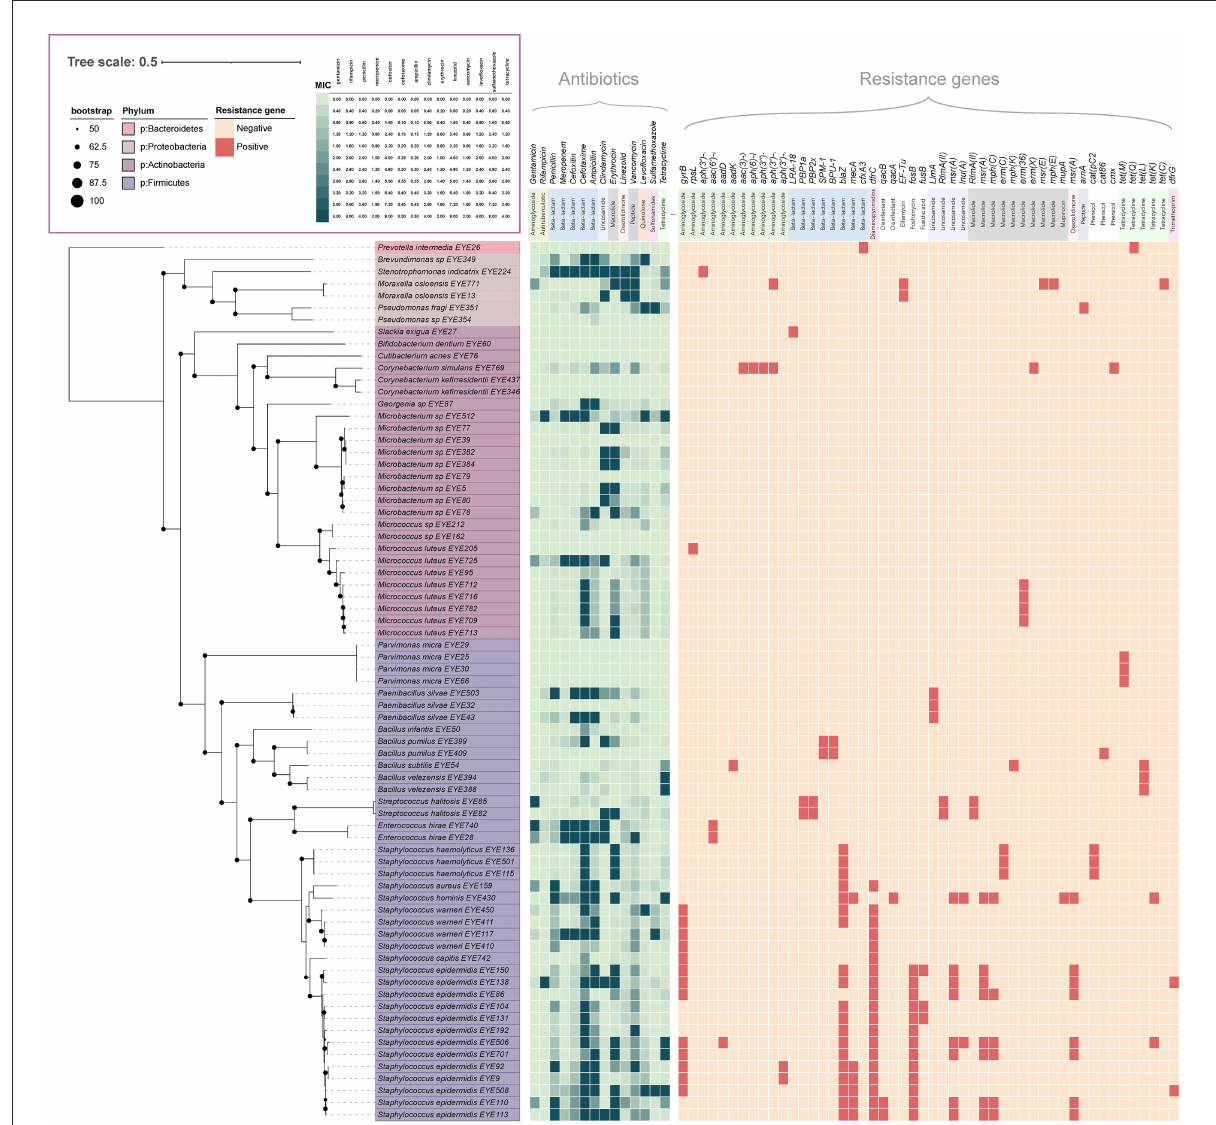
FIGURE3 Antibiotic resistance profile of ocular surface isolates. The phylogenetic tree was constructed from concatenated protein sequences using PhyloPhlAn and drawn using iTOL. Strains assigned to various phyla are displayed in different colors. All shades of green pixels represent MIC values. All red pixels represent antimicrobial resistance genes detected along each strain using RGI and ResFinder